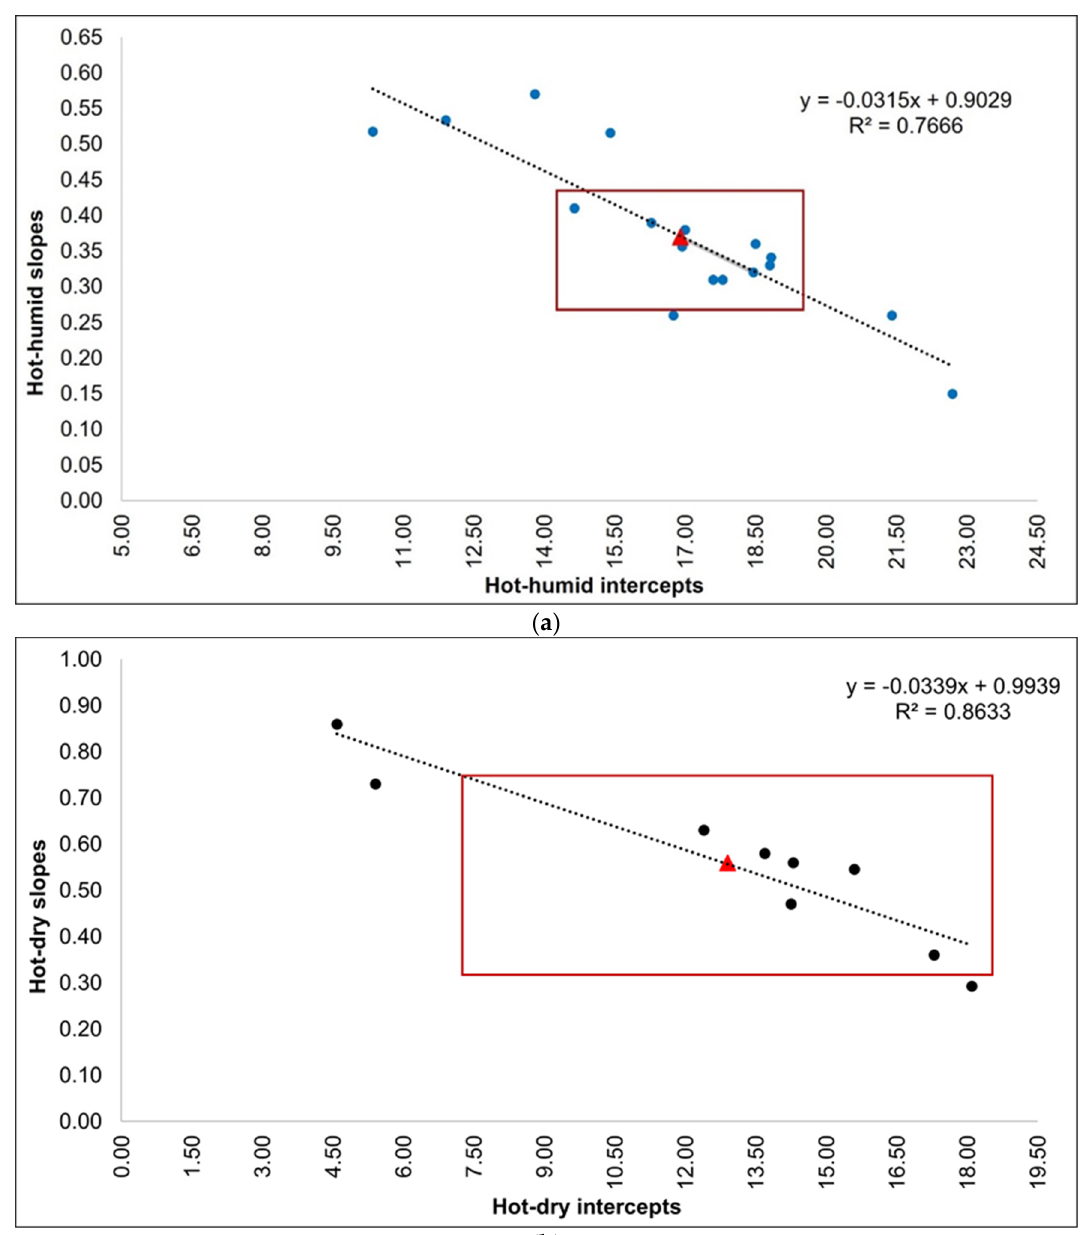
Figure 5. Bivariate plots of the slope vs. the intercept for linear models in hot climates: ( a , upper ) humid conditions and ( b , lower ) dry conditions. The red triangles represent the average value for each parameter. The rectangle represents the 1% significance limits.